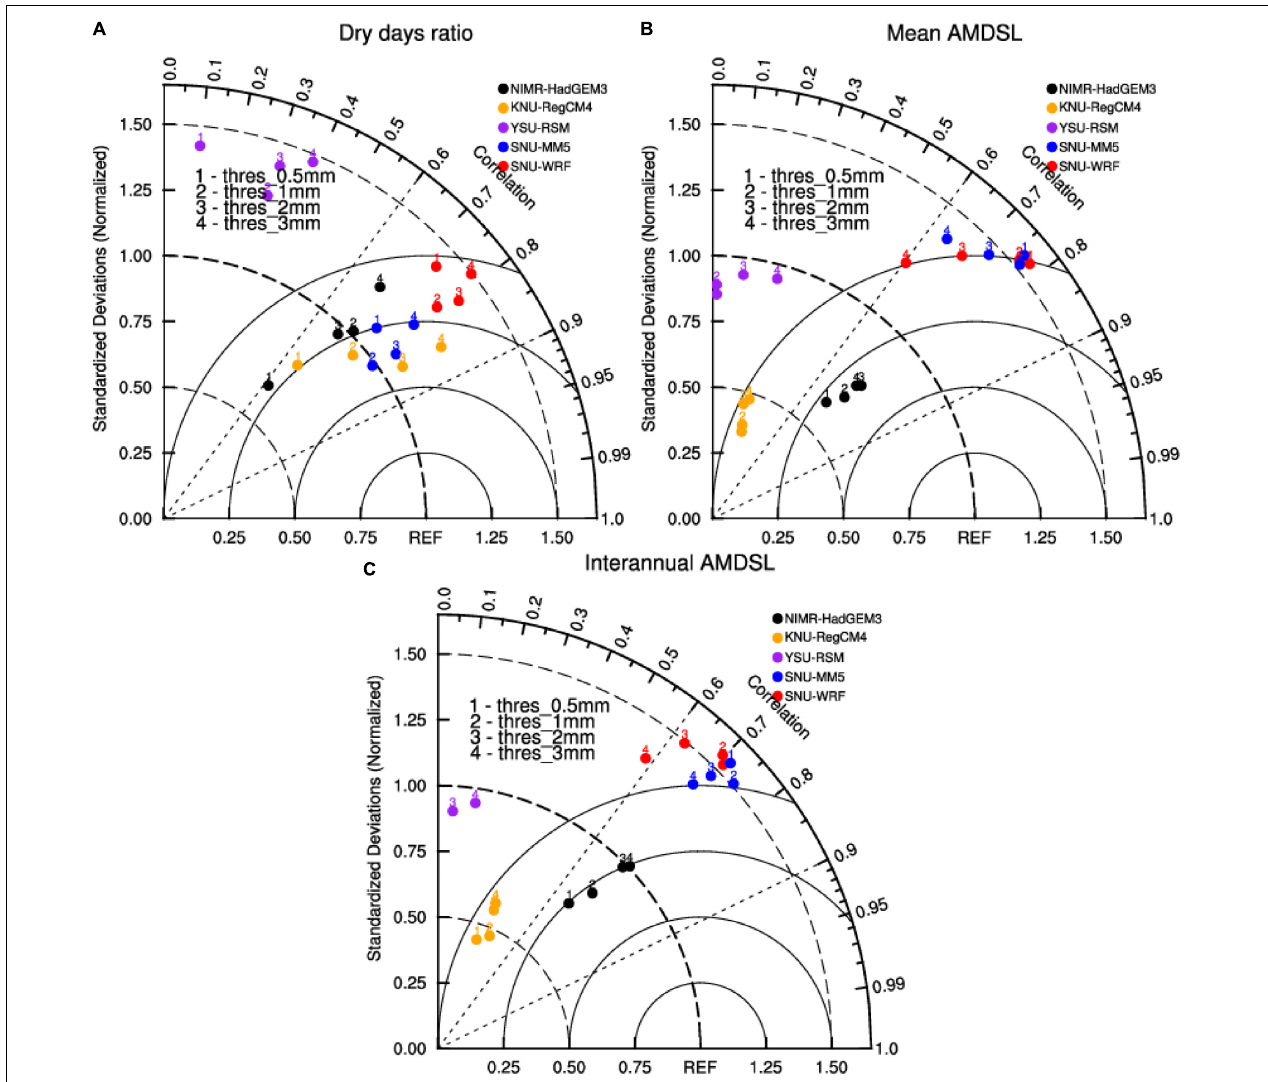
FIGURE 4 | Multivariable Taylor diagram displaying normalized statistical comparisons of SNU-WRF (red), SNU-MM5 (blue), YSU-RSM (purple), KNU-RegCM4 (orange), and NIMR-HadGEM3 (black) simulated climatological dry days ratio (A) , mean AMDSL (B ), and interannual variability of the AMDSL (C) , respectively. Numbers indicate four different thresholds for dry